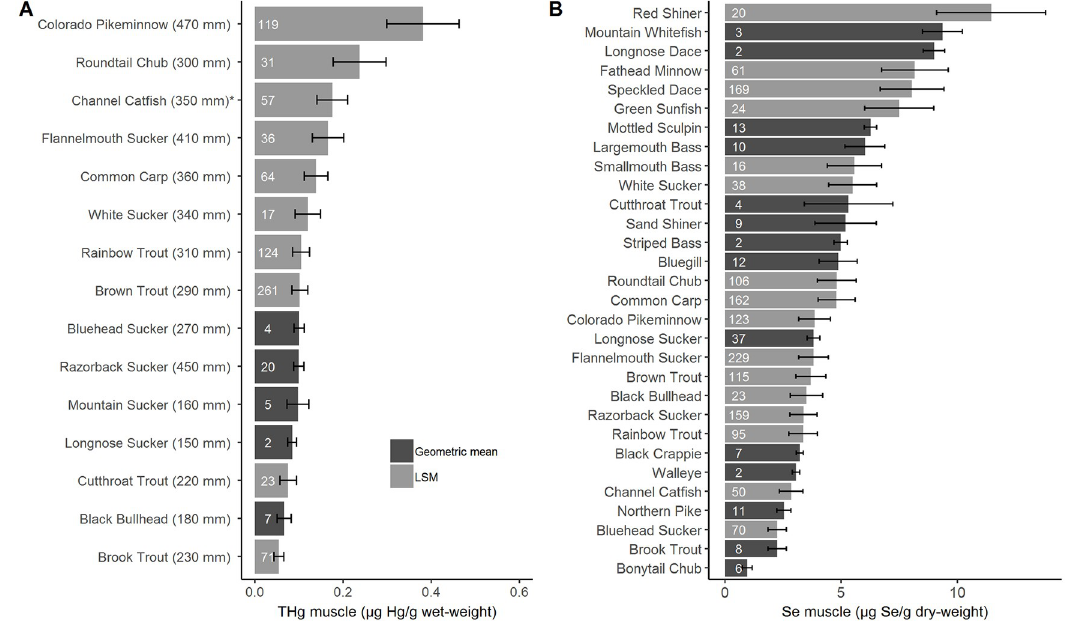
Fig 2. Mean total mercury (THg, Panel A) and selenium (Se, Panel B) concentrations in fish species of the Upper Colorado River Basin. Least-squares mean concentrations represent the mean THg and Se concentration in each species after accounting for fish size (only for THg), tributary, site, and year effects using a mixed effects model (black shaded bars) . THg concentrations in fish muscle were standardized to the respective median length of each species. An asterisk indicates there was no relationship between total length and THg; therefore, raw THg concentrations were used in the model. Geometric mean concentrations were calculated for species with insufficient spatial coverage to be included in the linear mixed effects models ( < 15 individuals and/or found in < 3 tributaries; grey shaded bars). Mean total length (mm) of each species is in parenthesis for THg. White numbers indicate sample size. Error bars represent 1 standard